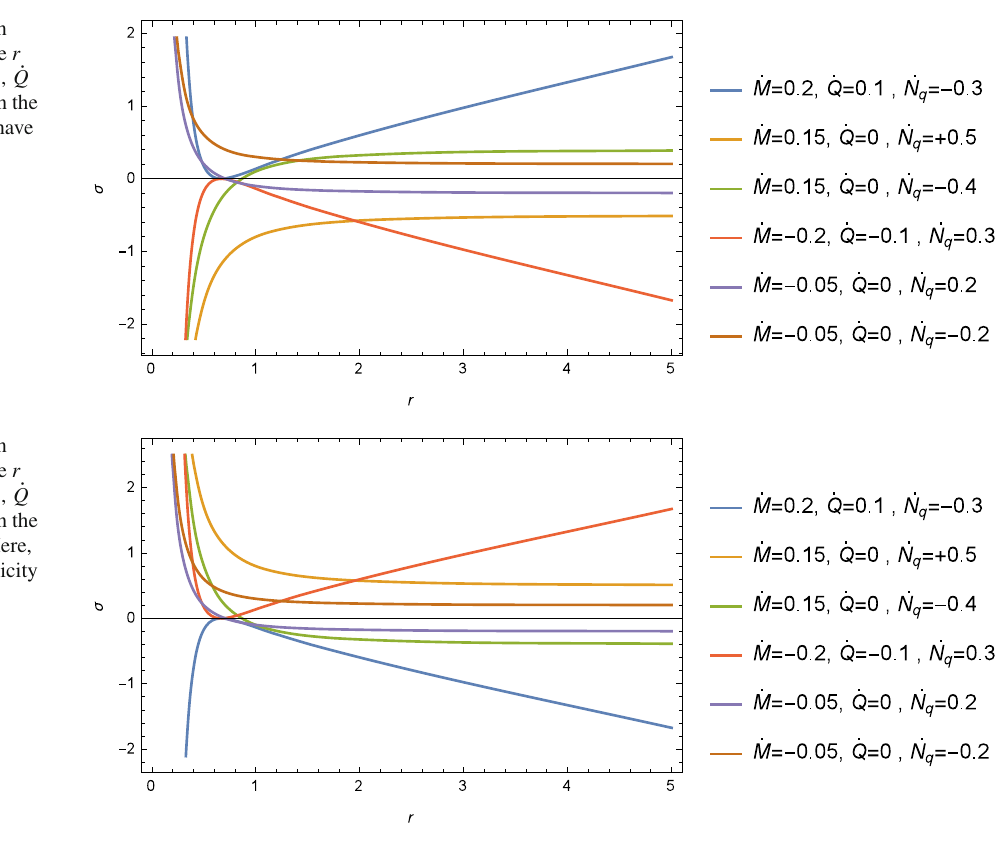
Fig. 15 Radiation-accretion density σ versus the distance r for some typical constant ˙ M , ˙ Q